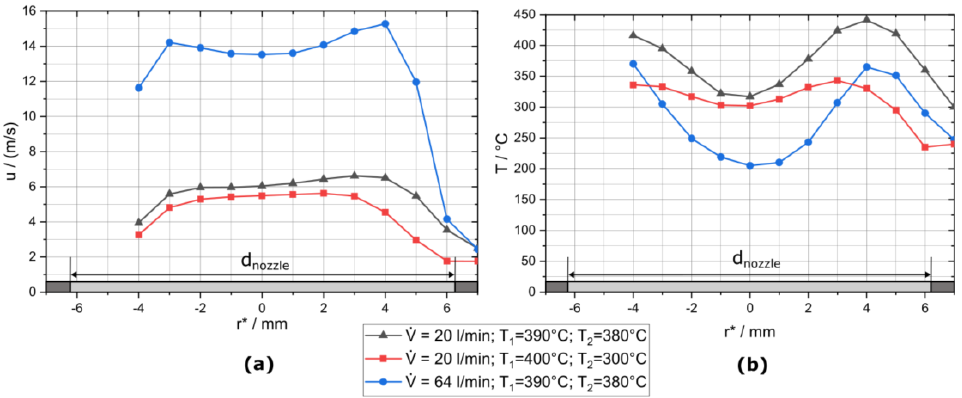
Figure 4. ( a ) Velocity and ( b ) temperature profile at the height of the fibres (10 mm distance from the nozzle outlet).